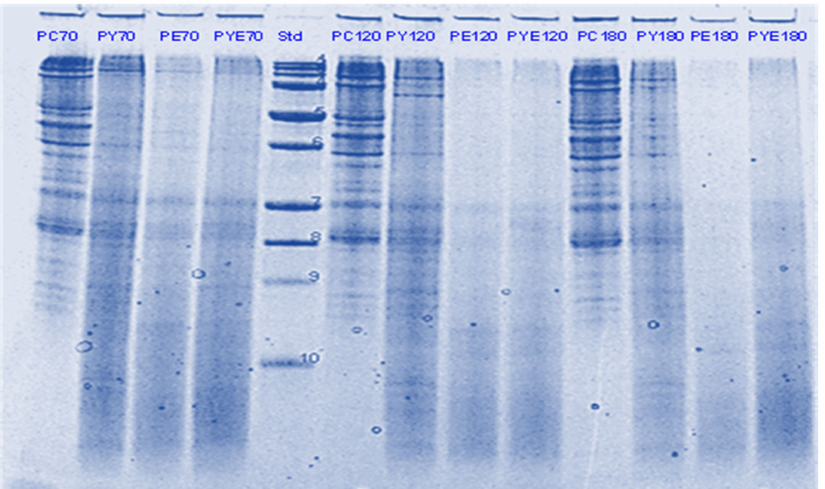
Figure 4. Tricine SDS-PAGE electrophoretogram of pea protein isolate after 70, 120 and 180 min of simulated oral-gastric-small intestinal digestion in the presence or absence of SunGold (Y) kiwifruit extract. PC, Pea protein (P) control without any digestive enzymes; PY, with added kiwifruit extract but no digestive enzymes; PE, with digestive enzymes but no added kiwifruit extract; PYE, with both digestive enzymes and gold kiwifruit extract. Numbers 70, 120 and 180 are the total digestion times in oral-gastro-small intestinal digestion (including 60 min of gastric digestion). Bands (1–10) in the molecular weight standard lane correspond to molecular weights 250, 150, 100, 75, 50, 37, 25, 20, 15 and 10